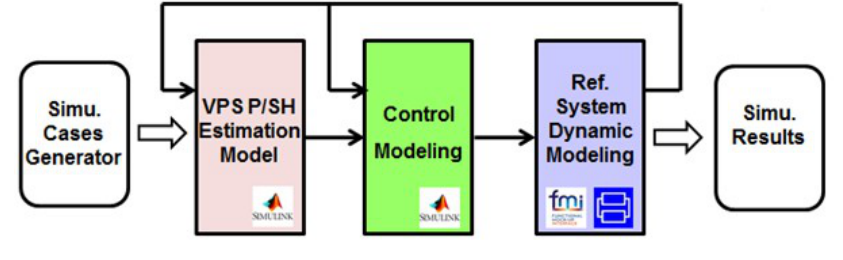
Figure 7. Model in the Loop (MIL) test framework.